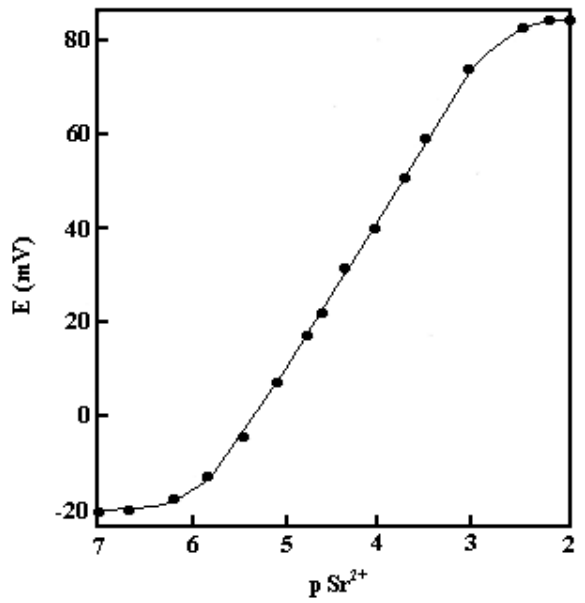
Figure 2. Calibration graph for the strontium ion-selective